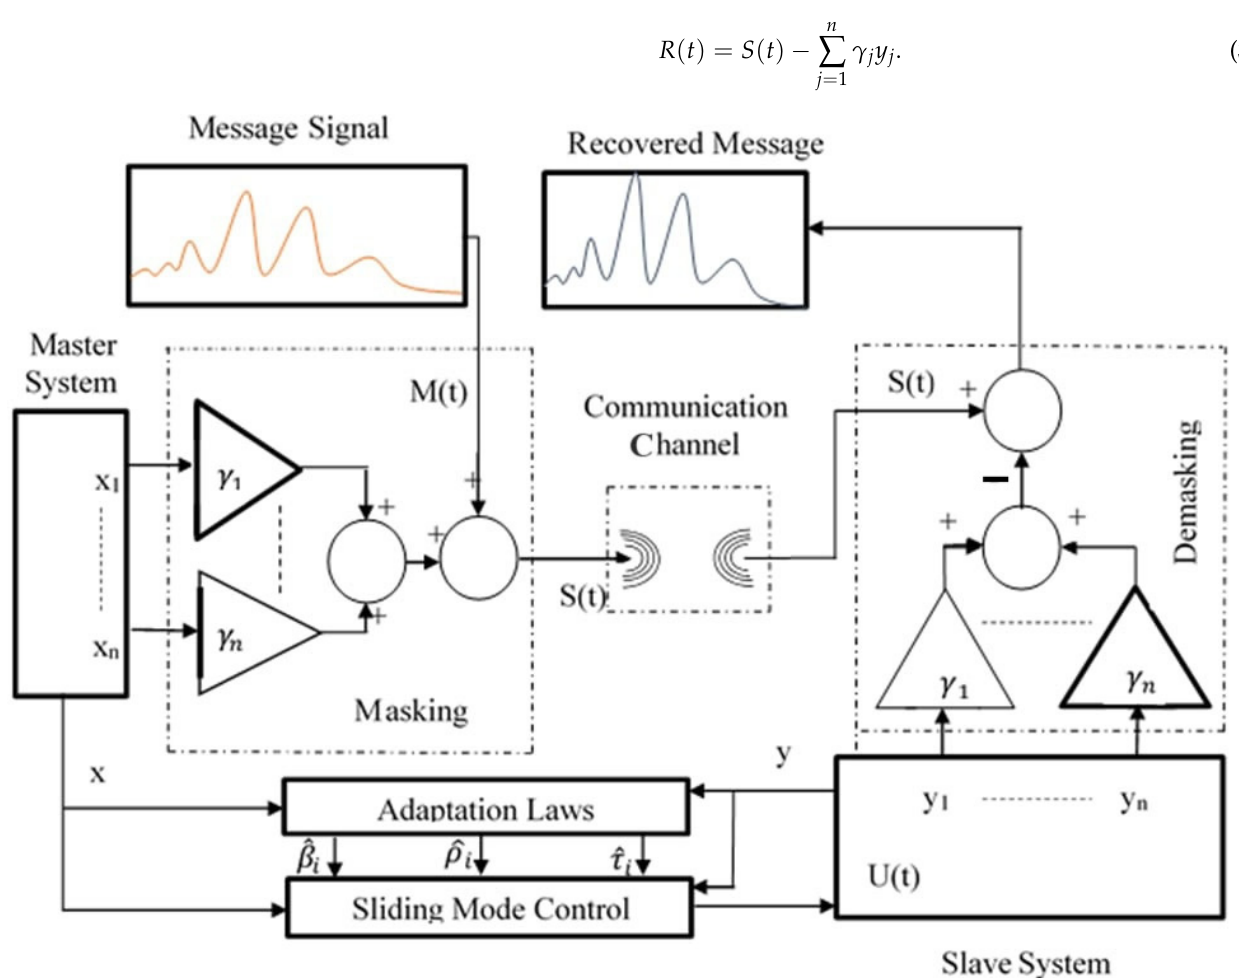
Figure 8. Chaotic secure communication structure based on the proposed approach.